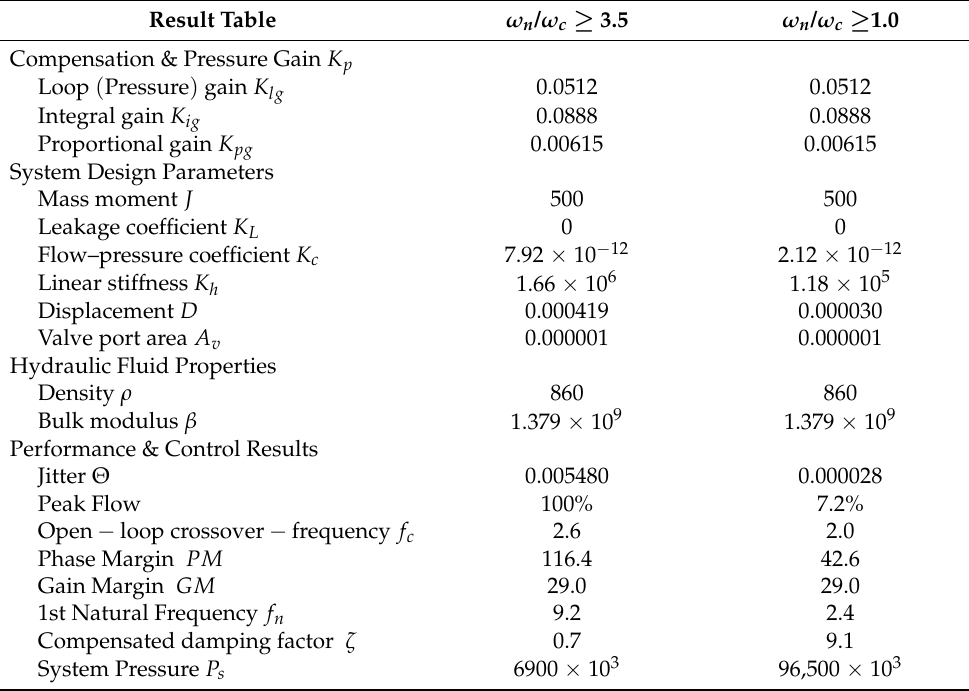
Table 3. System design results comparison of solutions 1 and